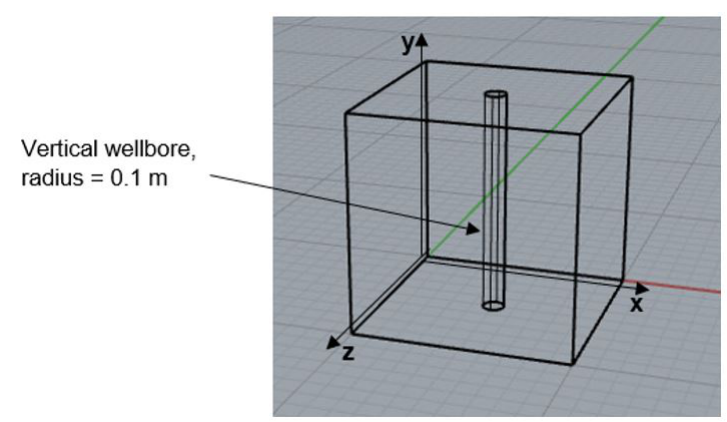
Figure 3. A CAD model depicting a well model in 3D; length = 10 m, width = 10 m, and wellbore radius = 0.1